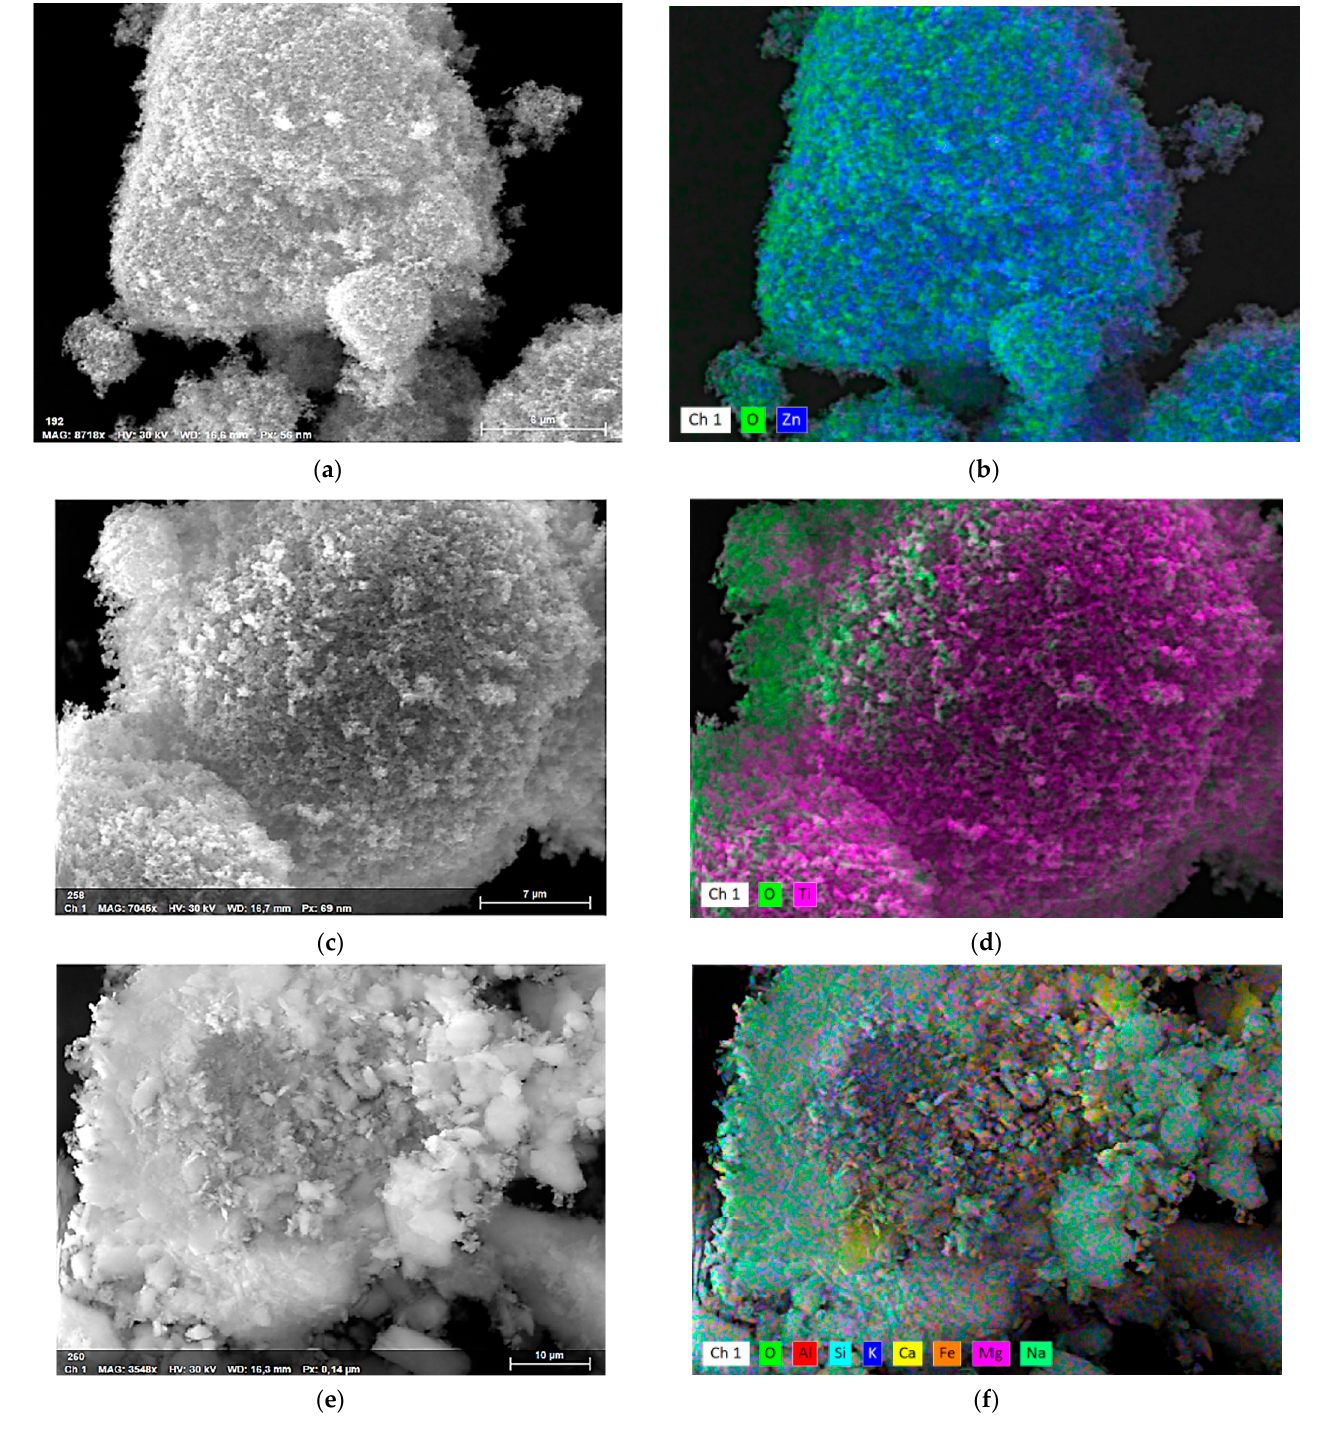
( c ) Figure 4. XRD patterns of the synthesized nanoparticles: ( a ) ZnO, ( b ) TiO 2 , and ( c ) zeolite. Figure 5 presents the Raman spectra recorded for each of the synthesized nanoparti- cles, which were further employed as active components in the decontamination